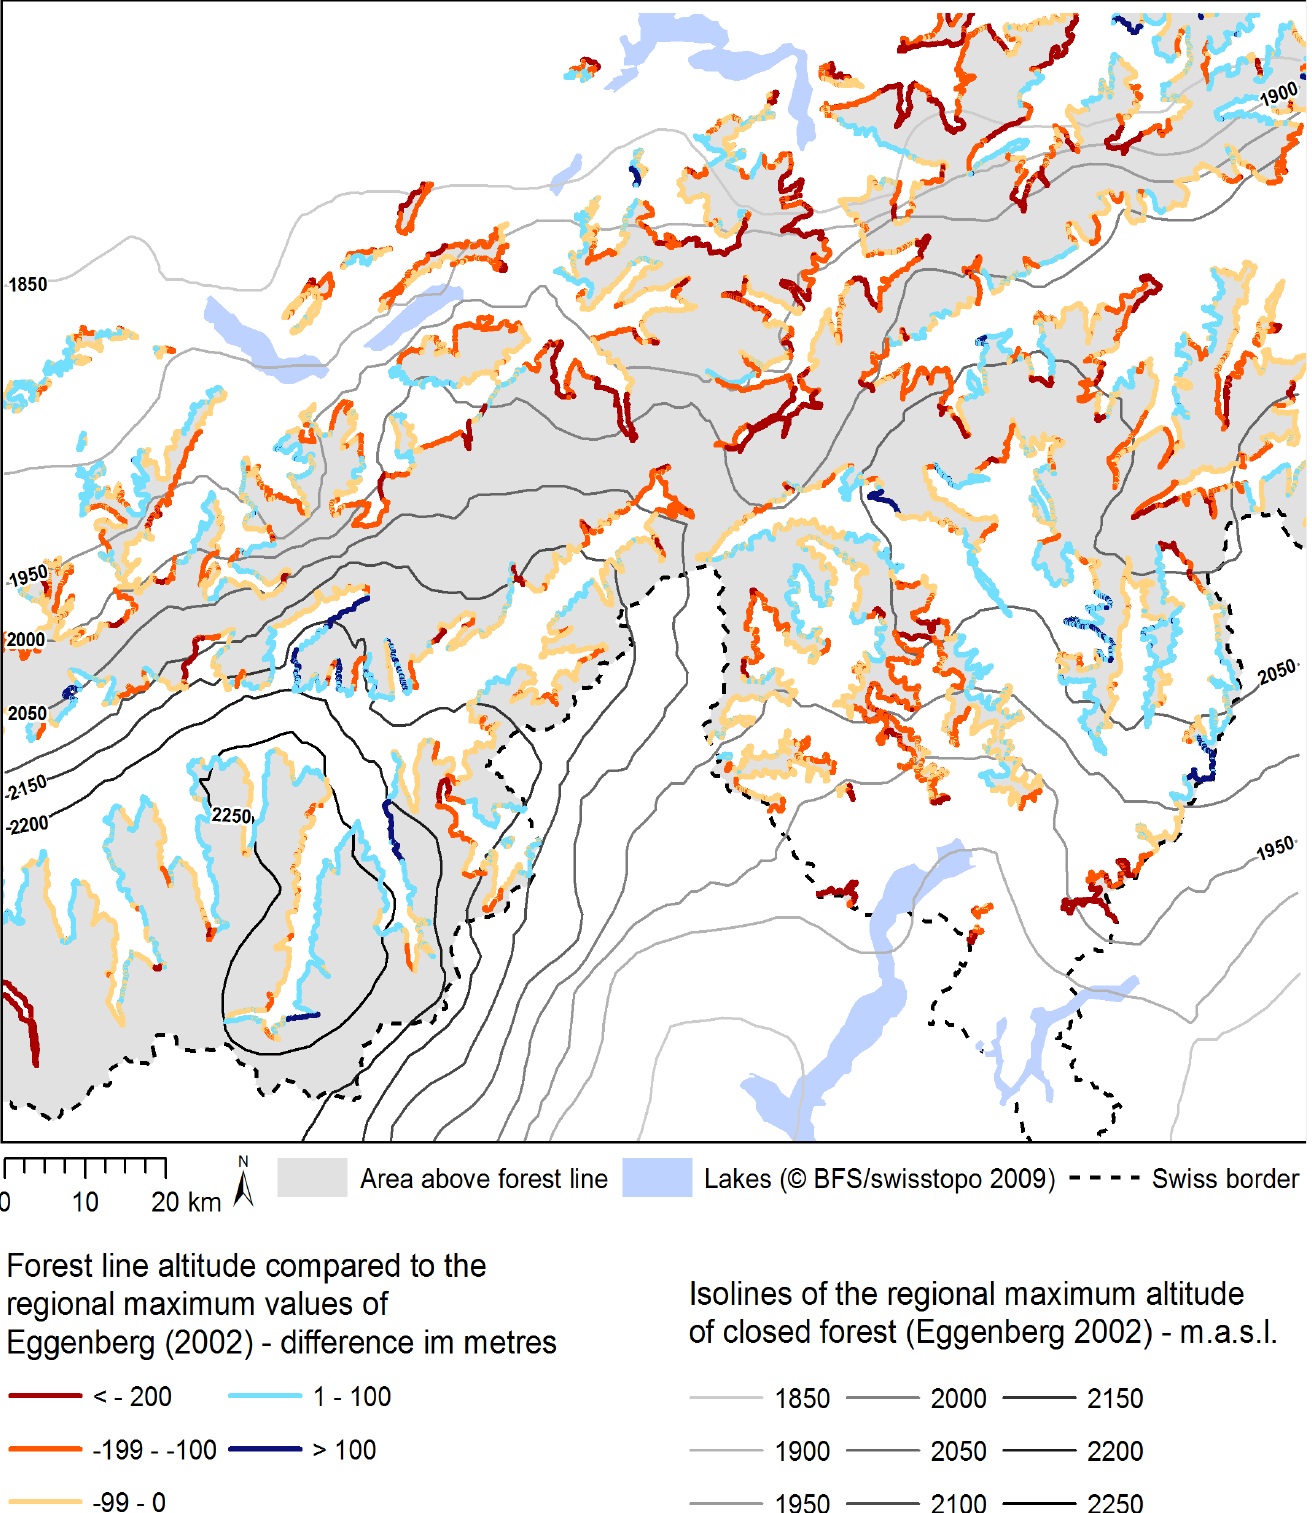
Figure 11. The red lines indicate that the modelled forest line is located lower than the regional maximum altitude of forest derived from the isolines given by Eggenberg (2002). The blue lines indicate that the modelled forest line is higher than the regional